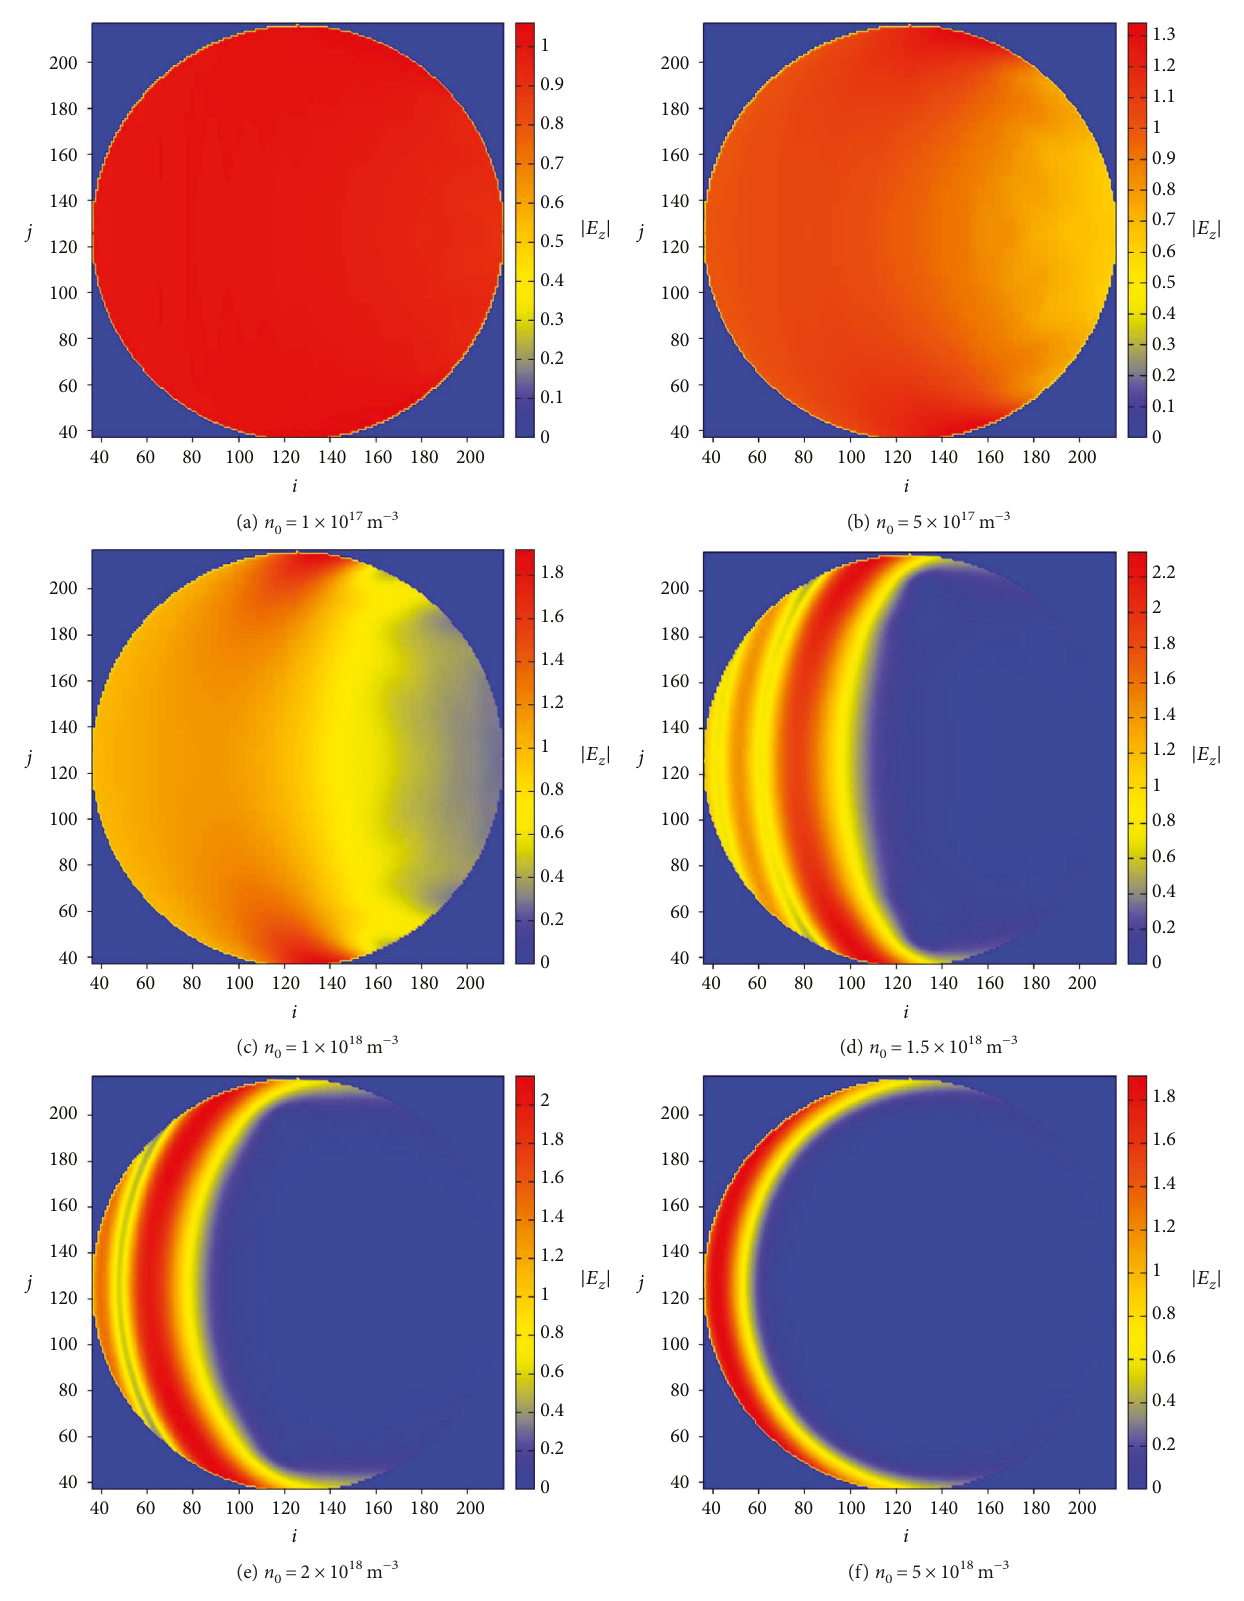
Figure 15: Magnitude of the electric fi eld, in volts/meter, within the inhomogeneous plasma cylinder obtained by the FDTD simulation for di ff erent central electron densities n . Incident wave frequency is set to f =10 GHz, and electron collision frequency is set to ν =500 × 10 6 0 in